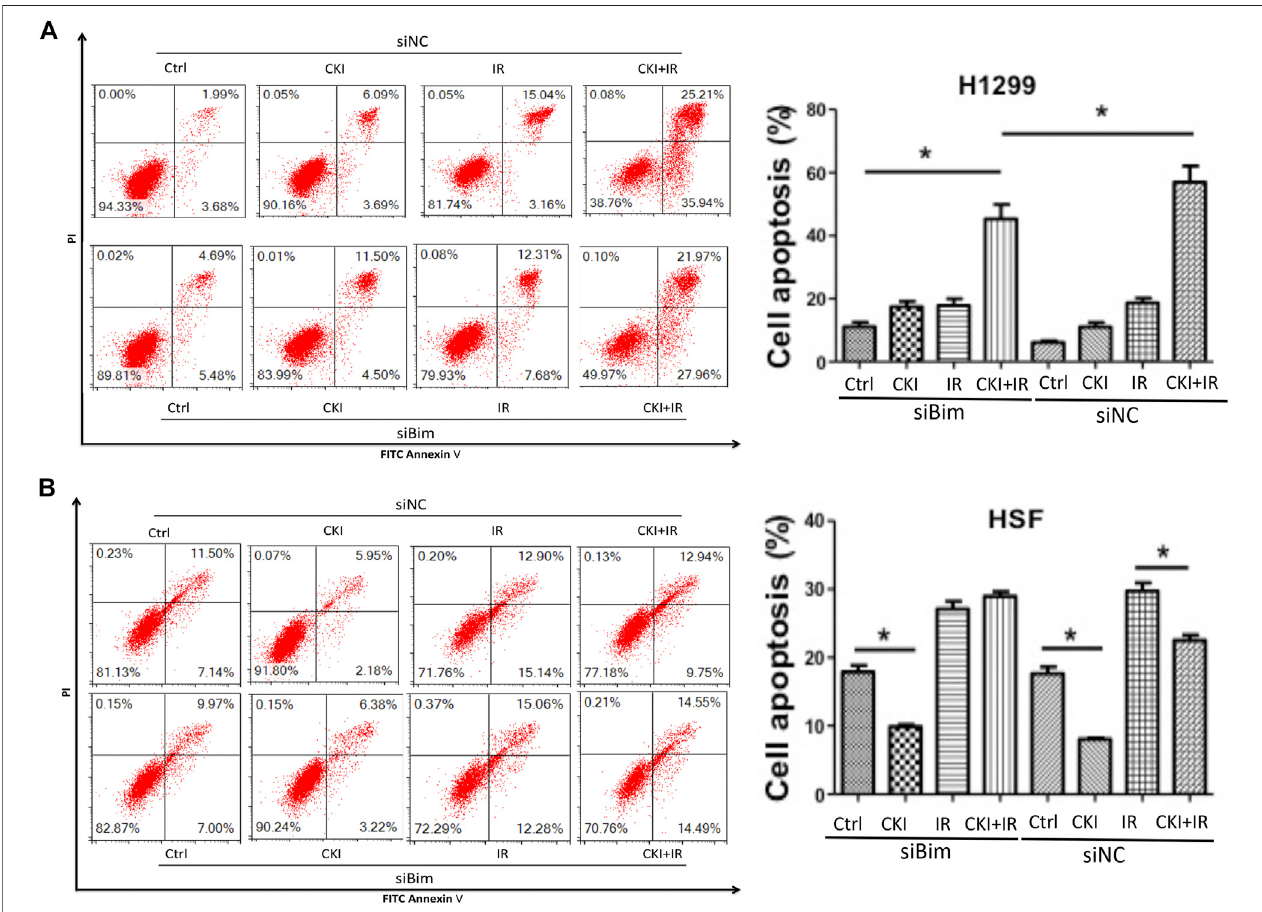
FIGURE 6 | Inhibiting Bim attenuated the differential effect of CKI in cancer and HSF cell apoptosis. (A, B) Cancer cell H1299 and HSF cells were treated with CKI (4 mg/ml), IR (4Gy) and combination of CKI and IR, respectively. Cell apoptosis was analyzed using fl ow cytometry. Values in bar graphs were given as the mean ± SD from three independent experiments performed in triplicate. *Indicates signi fi cant difference as compared to the accordingly group (* p < 0.05).